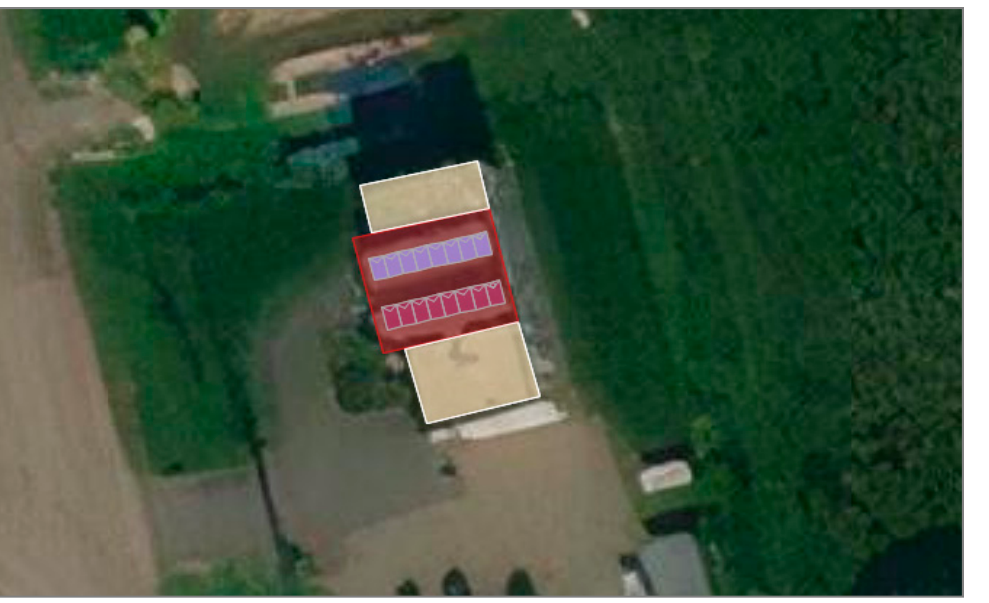
Figure 6. Model of the designed installation.